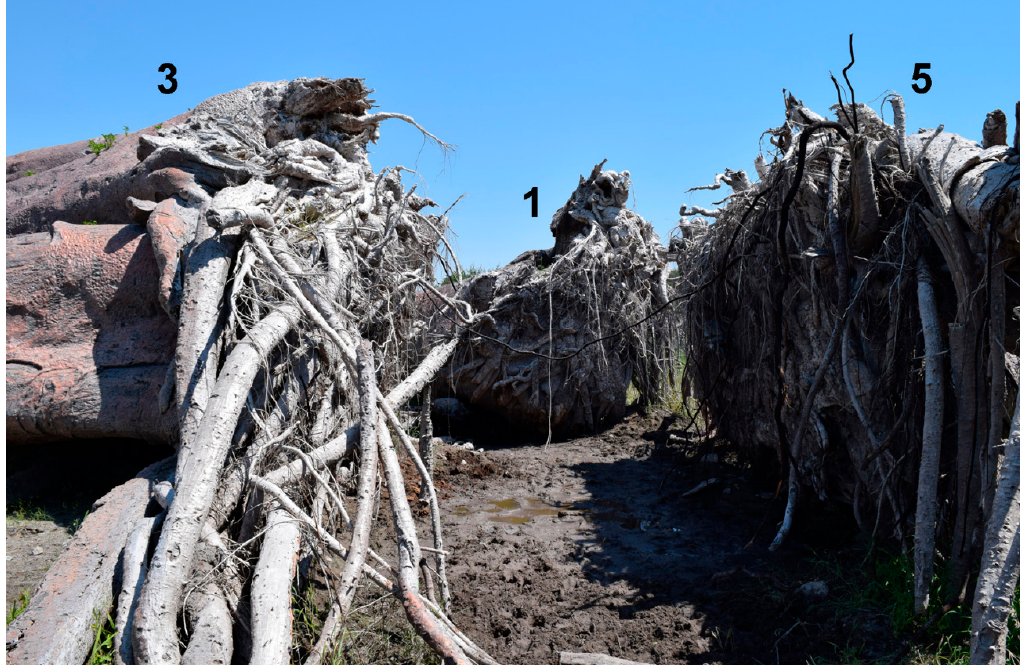
Figure 4. View of the fallen baobab taken from the ground level, with stem numbering.